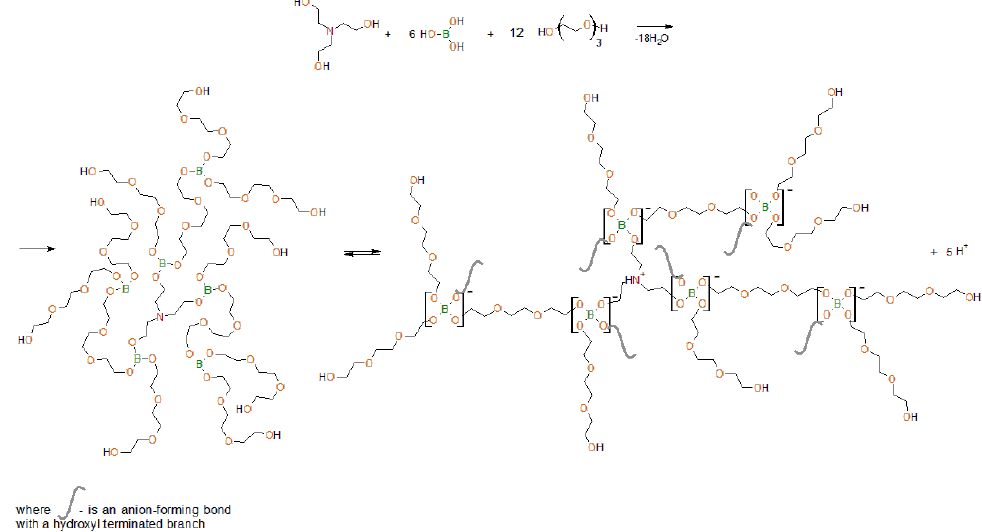
Figure 1. Scheme of synthesis of aminoethers of boric acid based on triethylene glycol (AEBA–TEG) and subsequent intermolecular complexation.